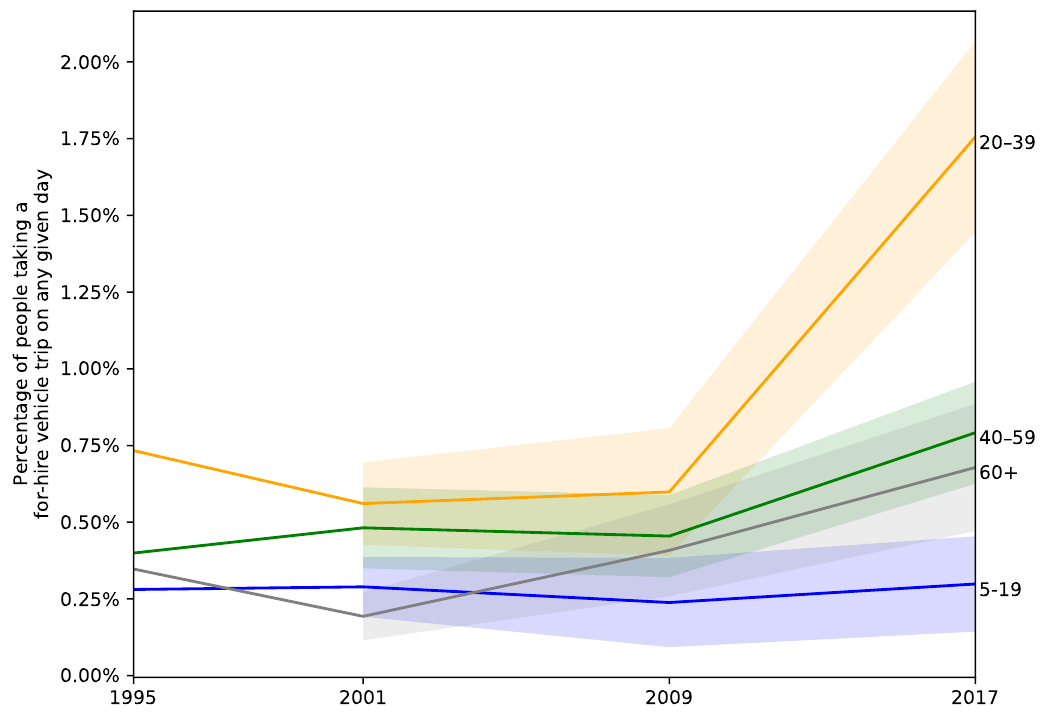
Figure 6. For hire vehicle use, by age (shaded areas represent 95% confidence